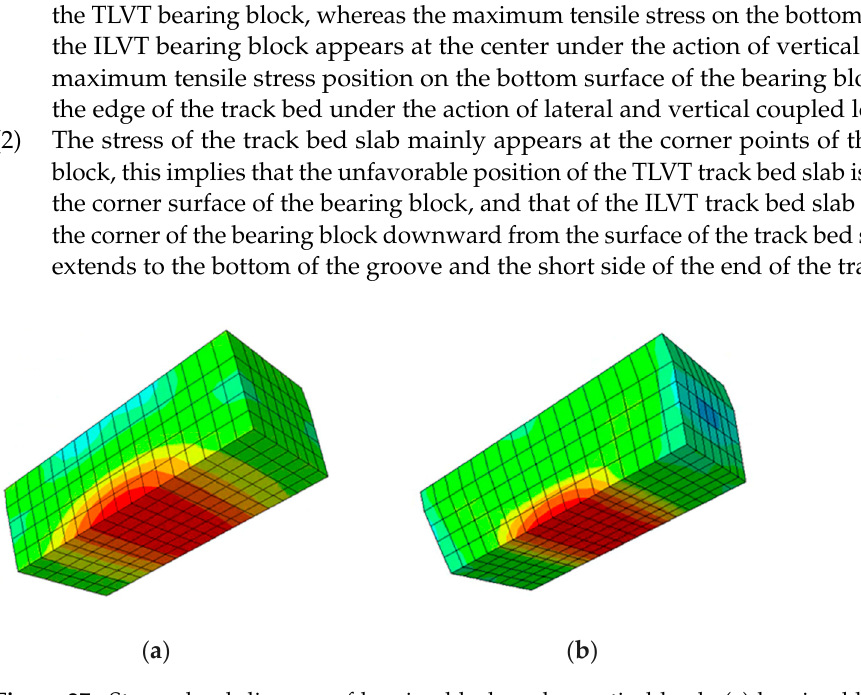
( b ) Figure 28. Stress cloud diagram of track bed under vertical load. ( a ) Track bed of TLVT. ( b ) Track bed of ILVT.